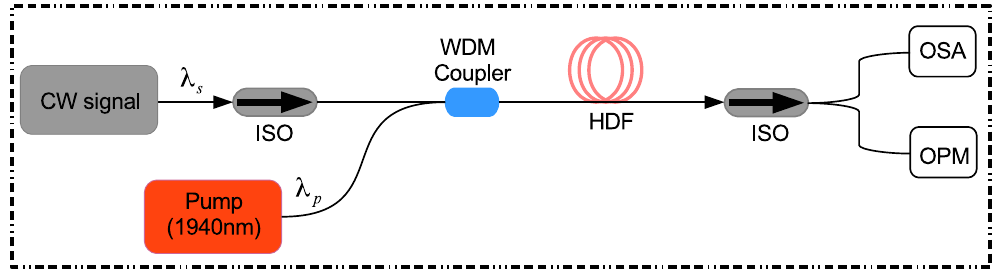
Figure 2. Schematic of the optimized HDFA, CW: Continuous wave laser, ISO: Isolator, WDM: Wavelength division multiplexed coupler, HDF: Holmium doped fiber, OSA: Optical spectrum analyzer, OPM: Optical power